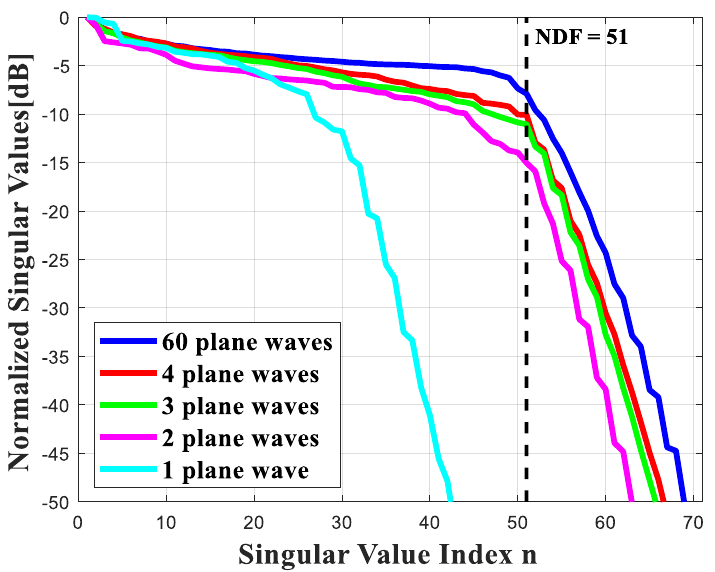
Figure 15. Comparison of the behavior of the normalized singular values of the linearized inverse scattering operator for various numbers of impinging plane waves for a double arc of circumference ID.